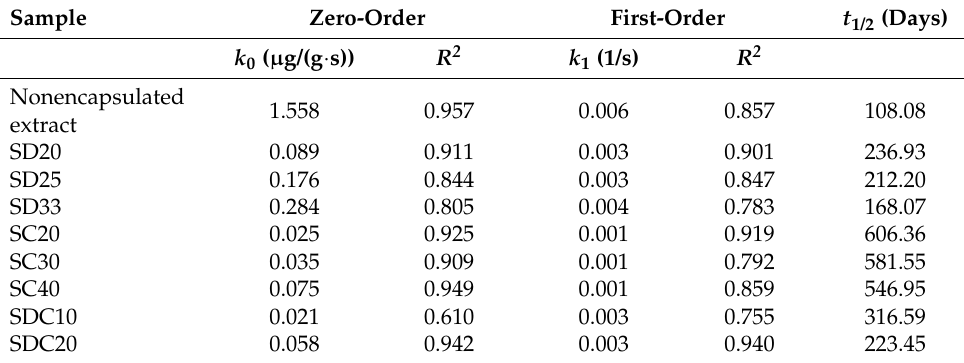
Table 4. Rate constants ( k 0 and k 1 ), coefficient of determination ( R 2 ), and half-life periods ( t 1/2 ) for degradation of nonencapsulated and encapsulated carotenoid-rich extracts obtained by different processes, during storage in the dark at 25 ◦